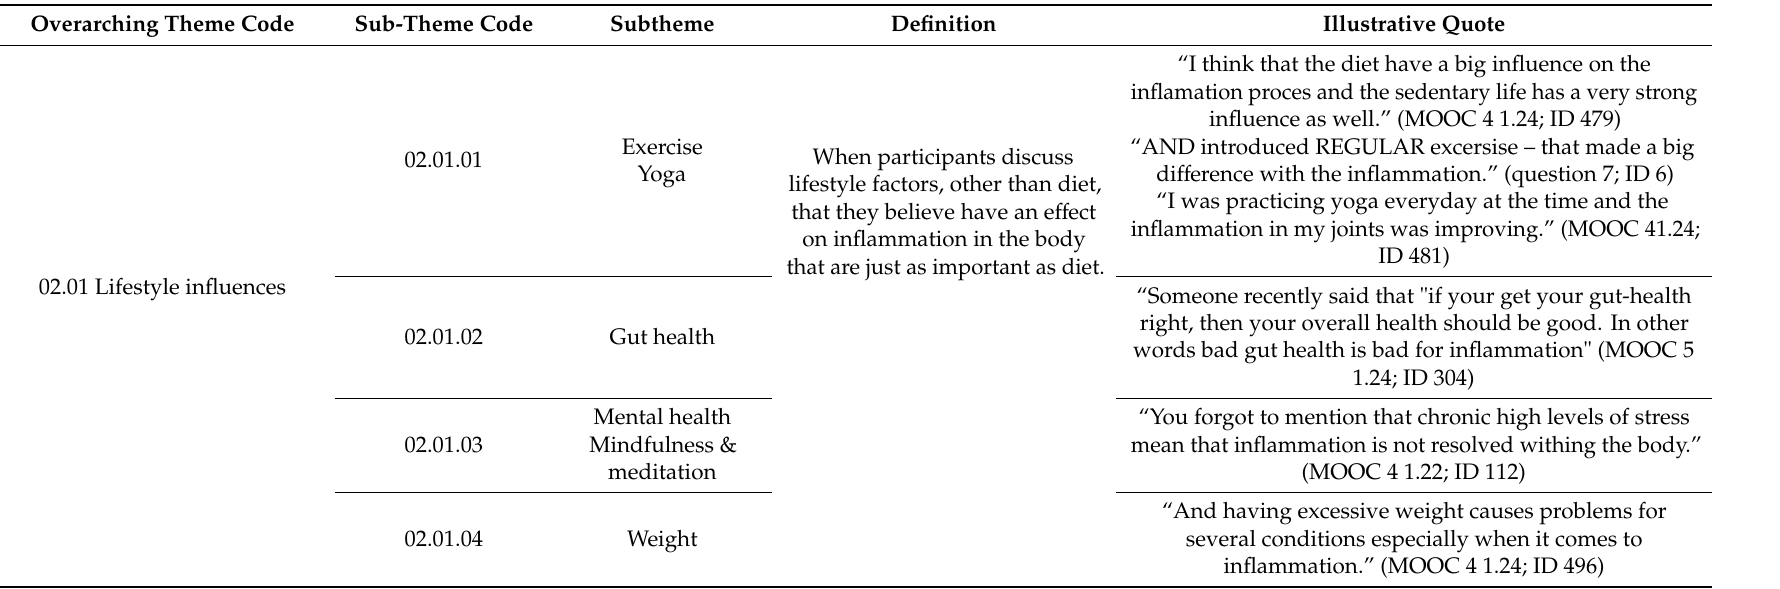
Table A4. Sample of the final coding